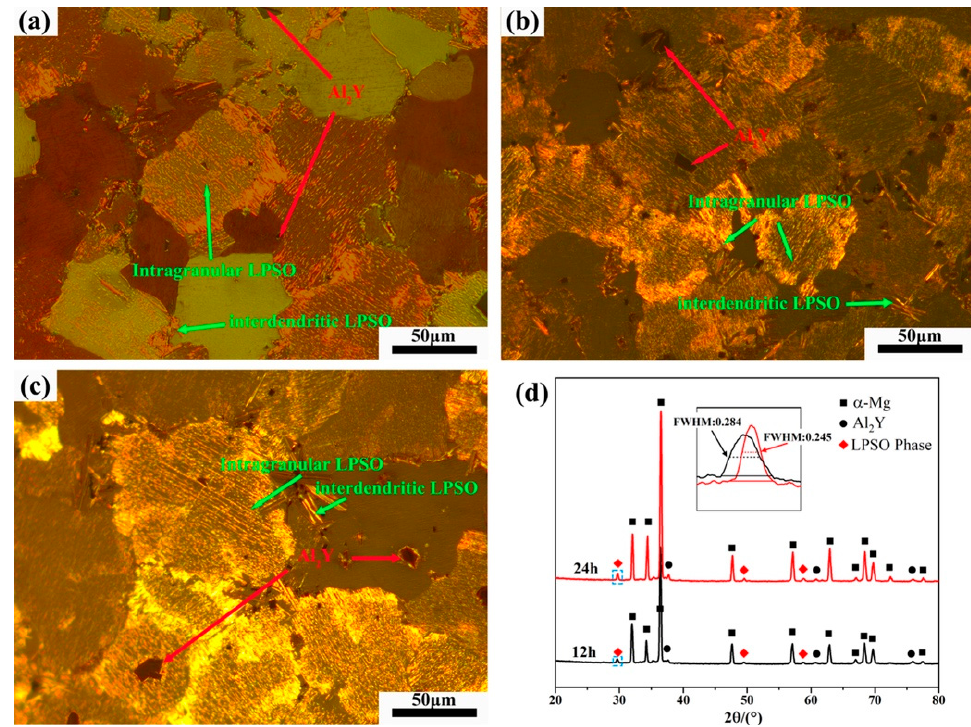
Figure 3. The OM images of solution ‐ treated alloys. ( a ) 1 h, ( b ) 12 h, ( c ) 24 h and ( d ) XRD patterns. The area fraction broken line diagram of the LPSO phase of the alloy after solution treatment at 450 °C for 1 h, 12 h and 24 h is shown in Figure 5 according to the statistics of Image Pro Plus software. It is found that with the prolongation of solution treatment time, the area fraction of the LPSO phase precipitated inside the alloy particles increased, which were 8.30%, 20.03% and 21.26%, respectively. This is the same conclusion drawn from the metallographic and XRD patterns shown in Figure 3.